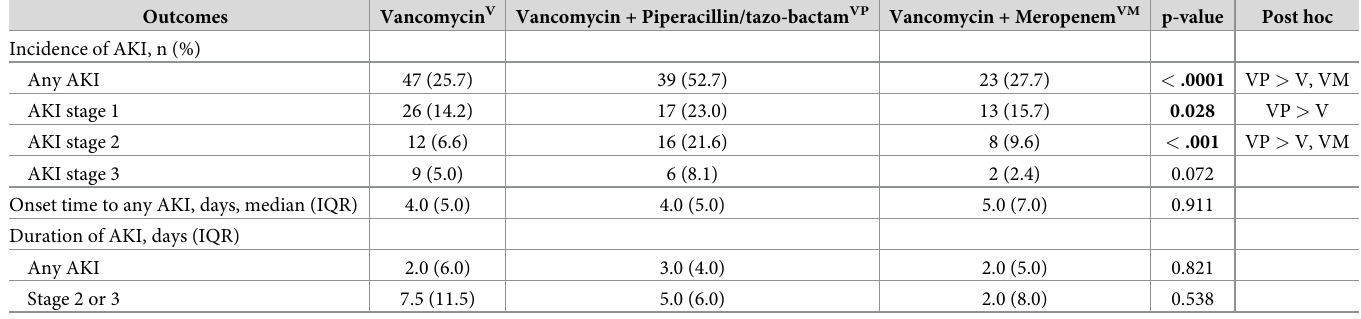
Table 2. Comparison between acute kidney injury development according to treatment